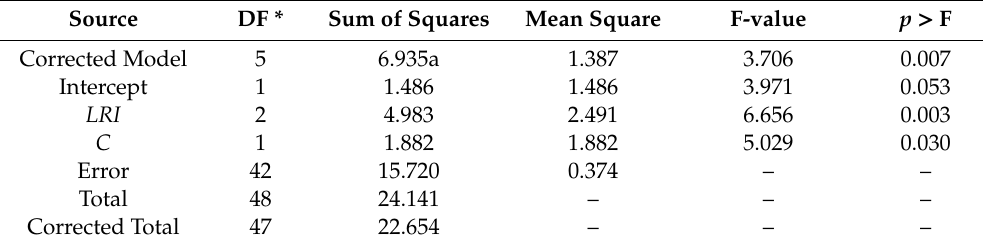
Table 10. Outcome of the last iteration for the ANOVA over Ln Ra .